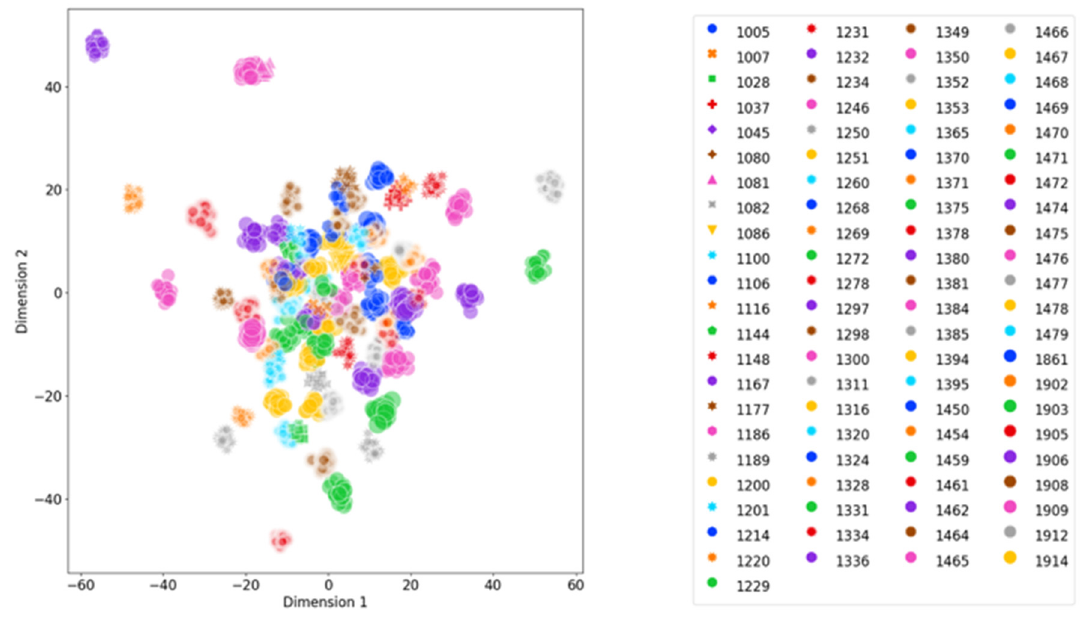
Figure 6. Cow ID distributed in 2-dimensional feature space with linear discriminant analysis